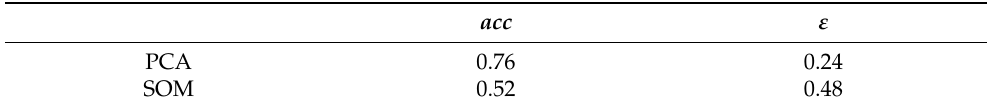
Table 4. Classification statistics for MLP classifier calculated for the test set for PCA and SOM feature extraction methods.